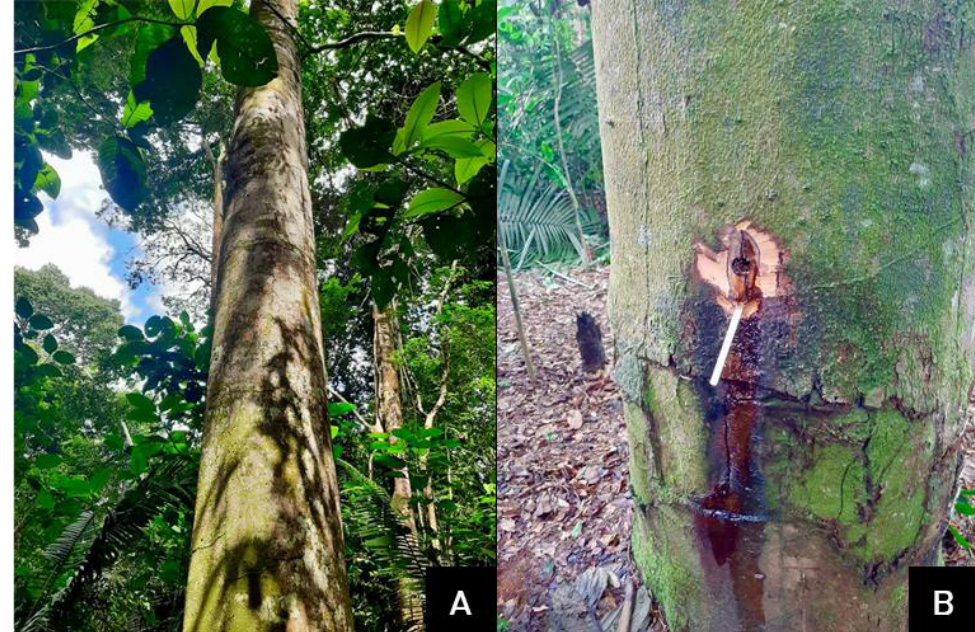
Figure 1. Copaiba tree. ( A ) Trunk of Copaifera reticulata Ducke ; ( B ) a representative image of extraction of oleoresin by artificial exudation from the trunk.